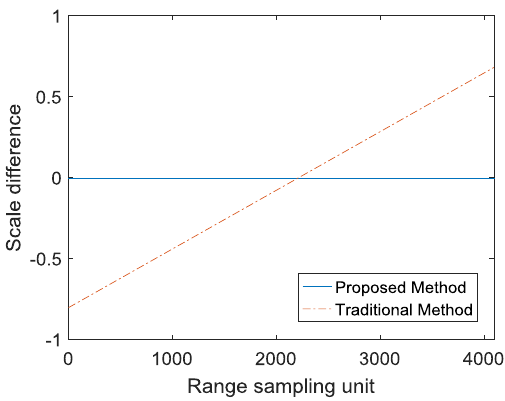
Figure 8. Scale difference of two methods.